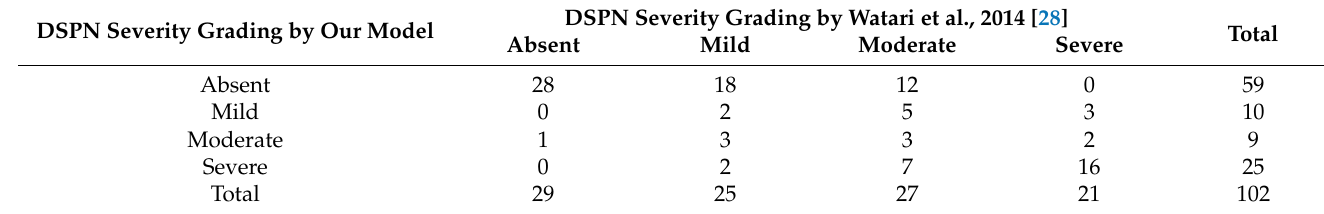
Table 10. The association among different DSPN severity groups and severity grading by Watari et al. [28] in the independent test dataset using Fisher exact probability test.